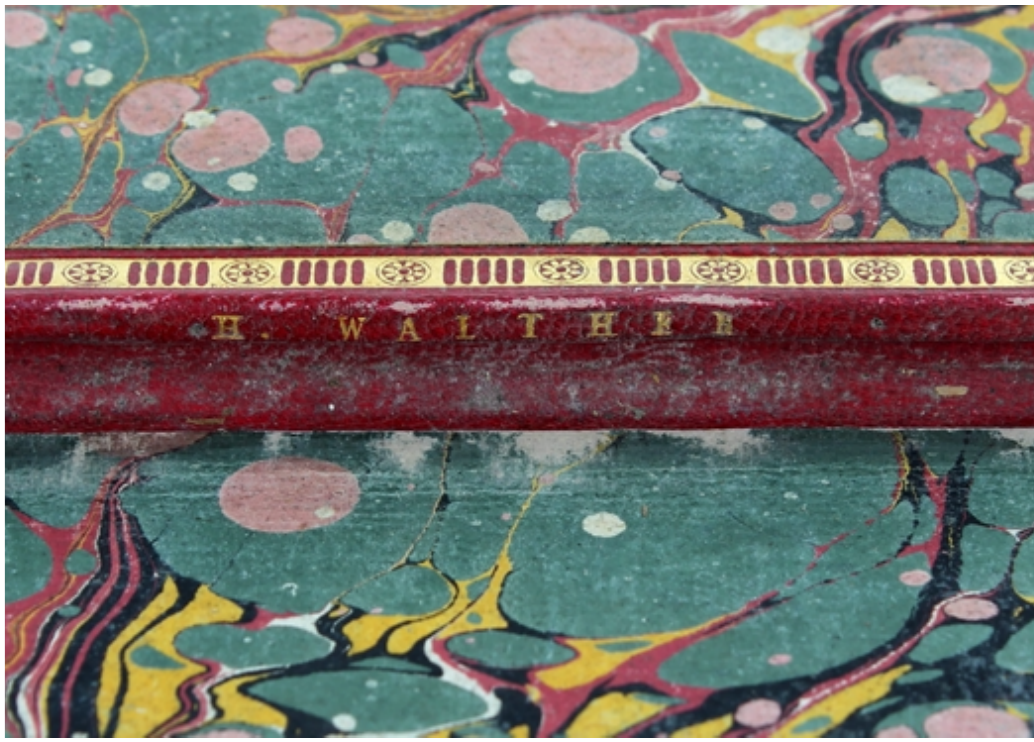
Fig. 17. The signature of binder Henry Walter lettered in gold on the edge of the upper board on 1784 Constitutions . Copyright, and reproduced by permission, of the Library and Museum of Freemasonry, London